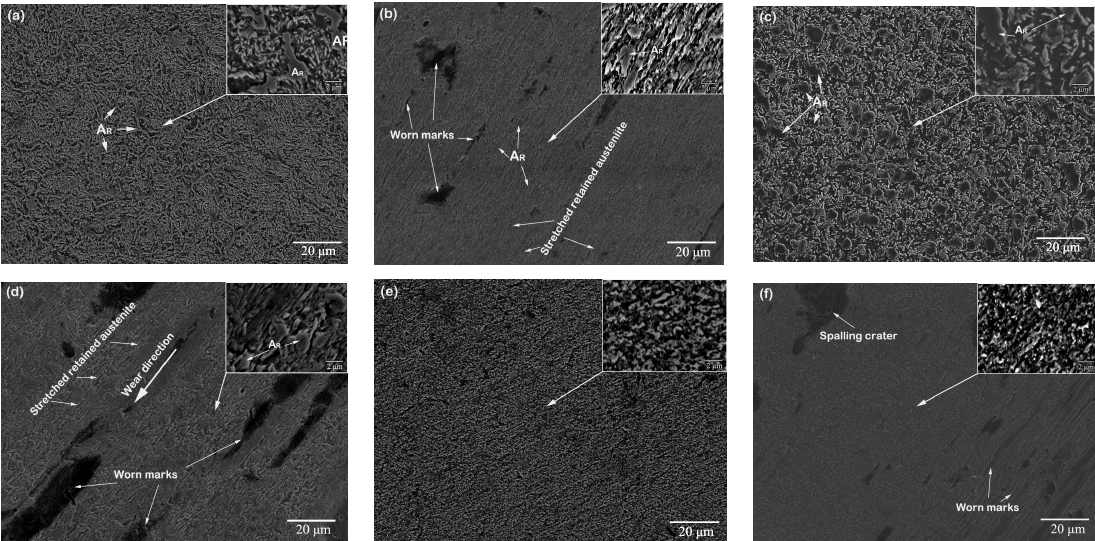
Figure 12. SEM micrographs of sub-surface material showing microstructural changes ( a , c , e ) before and ( b , d , f ) after wear test: ( a , b ) five-layer LFR, ( c , d ) 20-layer LFR, and ( e , f ) substrate.